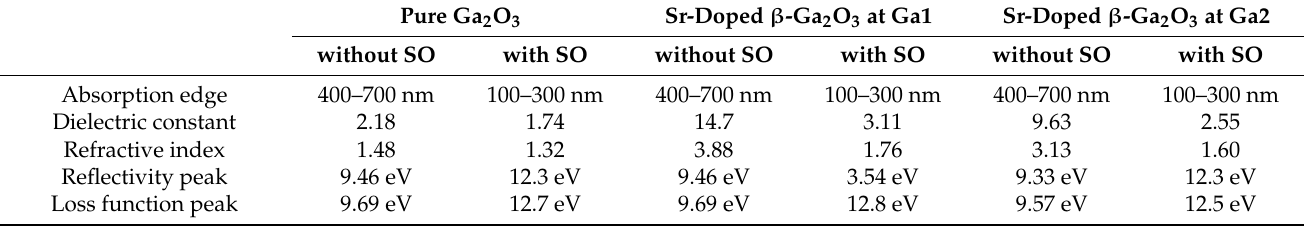
Table 7. Calculated optical properties without and with scissor operator (SO). Pure Ga 2 O 3 Sr-Doped β -Ga 2 O 3 at Ga1 Sr-Doped β -Ga 2 O 3 at Ga2 without SO with SO without SO with SO without SO with SO Absorption